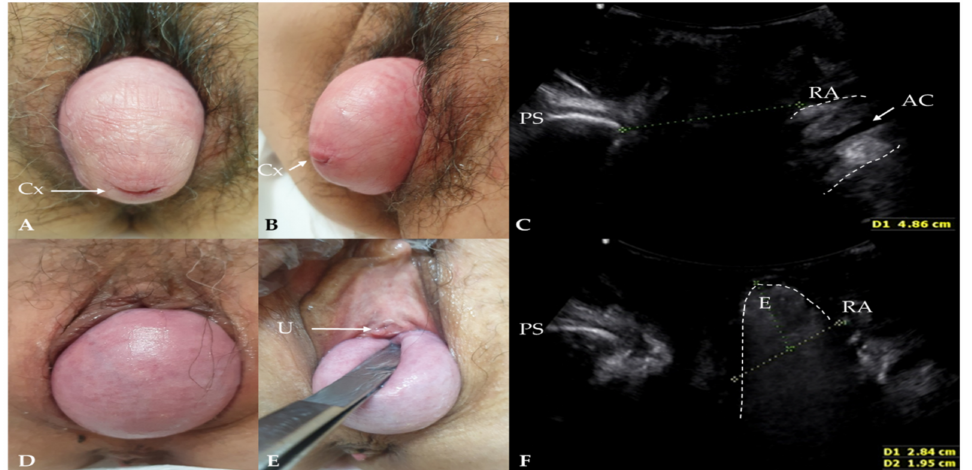
Figure 1. Clinical findings and translabial ultrasonography in patients with pelvic organ prolapse (POP) in the maximal Valsalva phase. ( A – C ) A patient with POP-Q stage IV without rectocele or enterocele. Cx: cervical os; AC: anal canal; PS: pubis symphysis; RA: rectal ampulla. ( D – F )